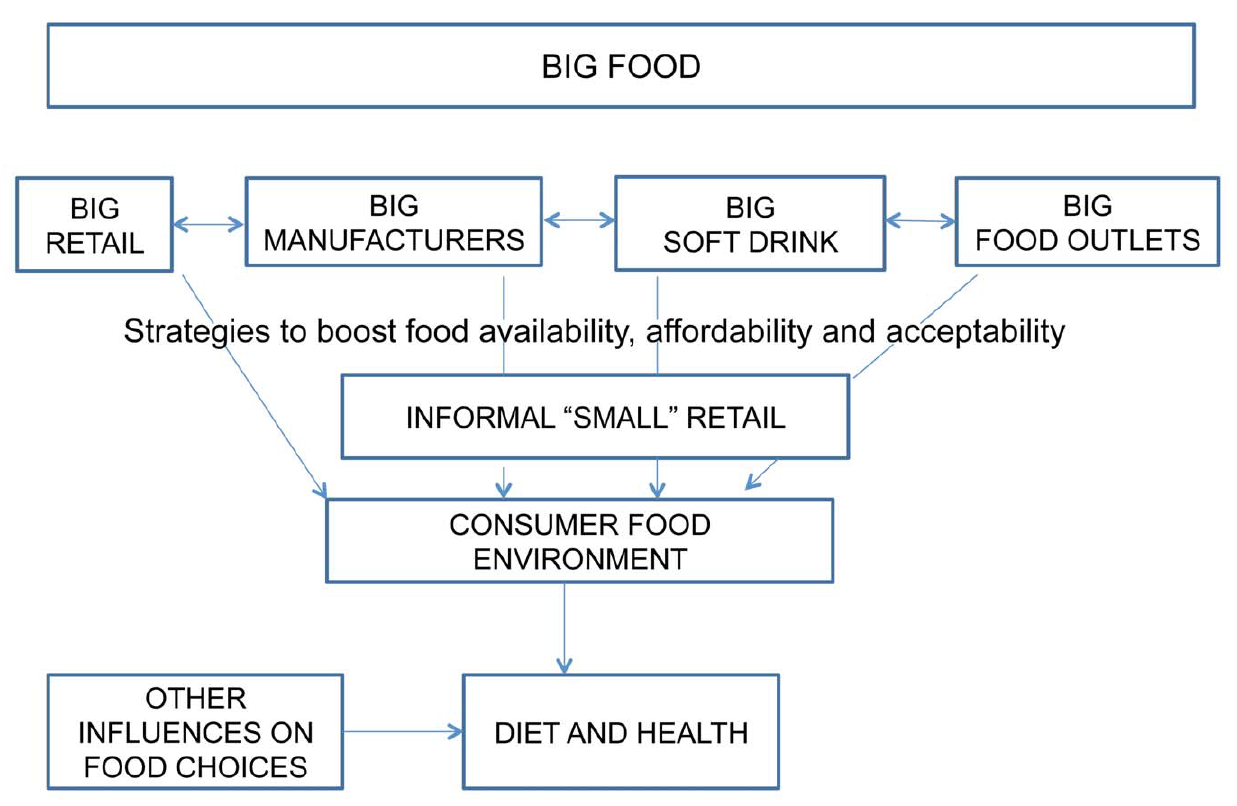
Figure 1. Hypothesized link between Big Food and the consumer food environment.